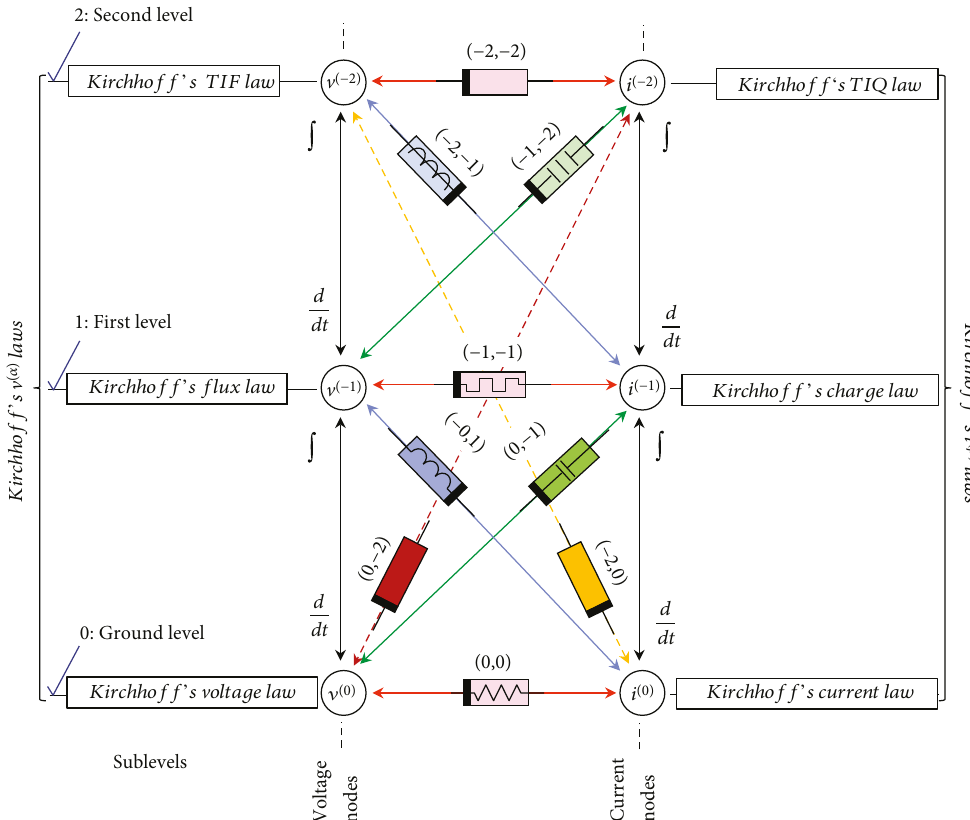
Figure 1: Fragment of storeyed structure of nonlinear higher-order